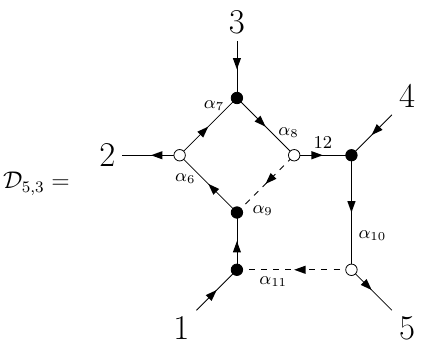
Figure 9 . On-shell diagram for a 5-point NMHV amplitude. The full amplitude is recovered by summing over 3 ↔ 4